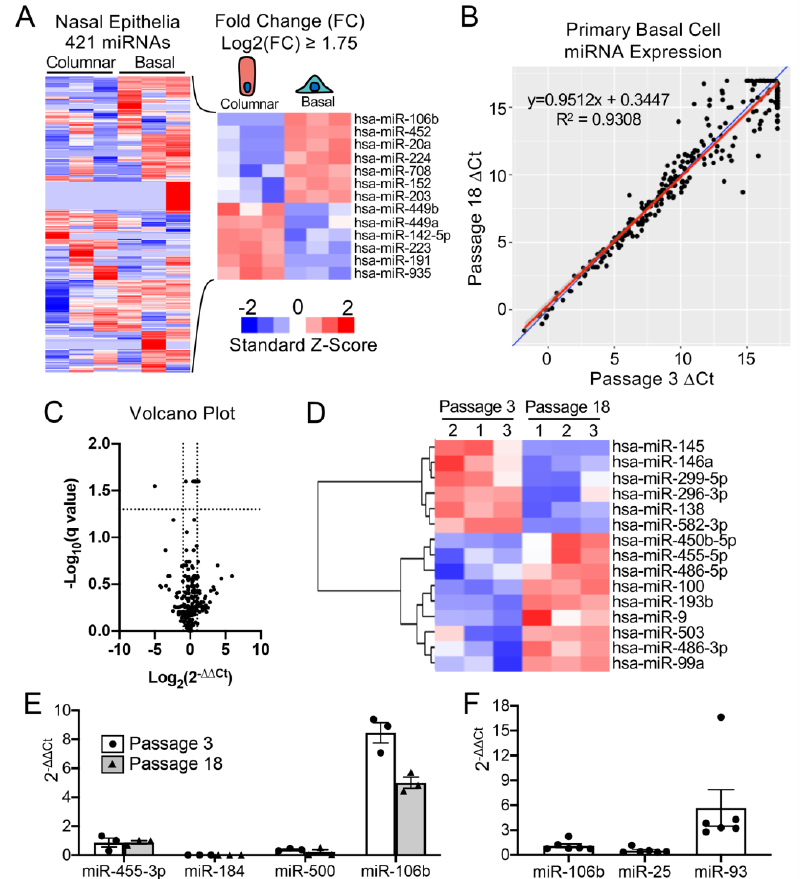
Figure 1. mMiR-106b is stably expressed at high levels in proliferating human basal cells. ( A ) Published data of miRNAs detected by high throughput sequence profiling of nasal basal cells and columnar cells (Accession: GSE22145) were used to generate a heatmap of 421 expressed miRNAs (left) and 13 miRNAs with a Log2 fold difference greater than 1.75 or less than −1.75 (right). ( B ) Correlation of miRNA expression in basal cells at Passage 3 and Passage 18 detected by qPCR array with the blue line represents a theoretical perfect correlation (x = y), and the red line represents linear regression model. ( C ) Volcano plot of miRNA array data indicating genes that were differentially expressed between passages 3 and 18. ( D ) Heatmap of miRNA array data with unsupervised hierarchical clustering of 15 miRNAs (of 252 detected) with an absolute fold change ≥ 2 and an unadjusted P value of ≤ 0.05. ( E ) Relative quantification of candidate basal cell-specific miRNAs, miR-184, miR-500, and miR-106b compared to a known basal cell-specific miR-455-3p. Freshly isolated primary human tracheobronchial cells were passaged 3 (P3) and 18 (P18) times in SAGM-EA media ( N = 3). ( F ) Relative quantification of miRNAs belonging to miR-106b-25 cluster in passage 3 basal cells ( N = 6). Each dot represents one donor.